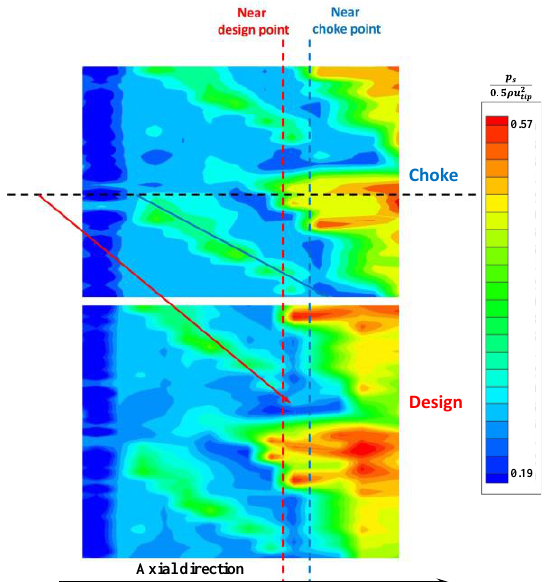
Figure 20. The comparison of the distribution of the R1 pressure coefficient between the near choke and design conditions .